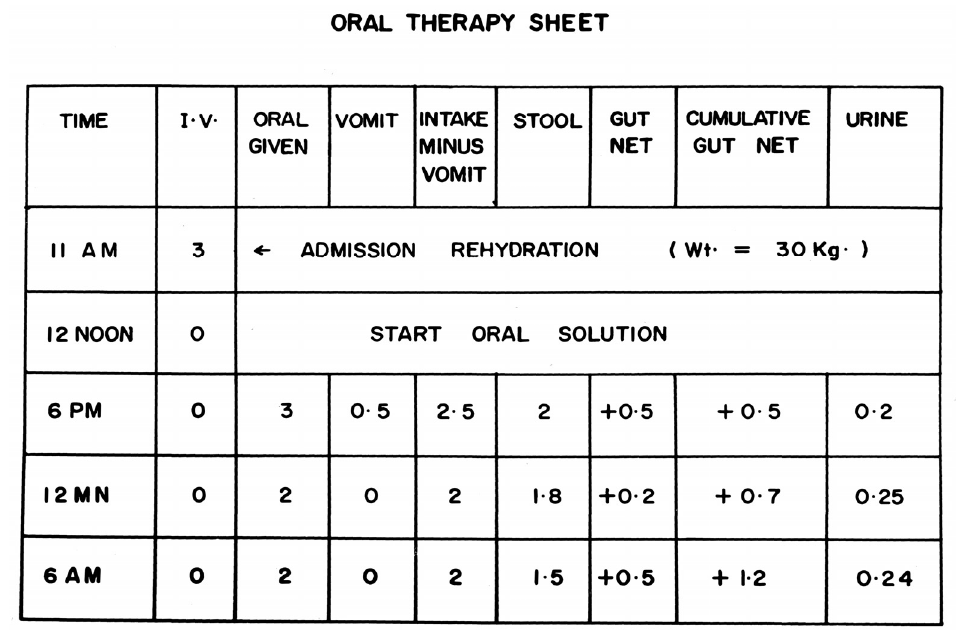
Figure 1. ORT I & O SHEET: figures in